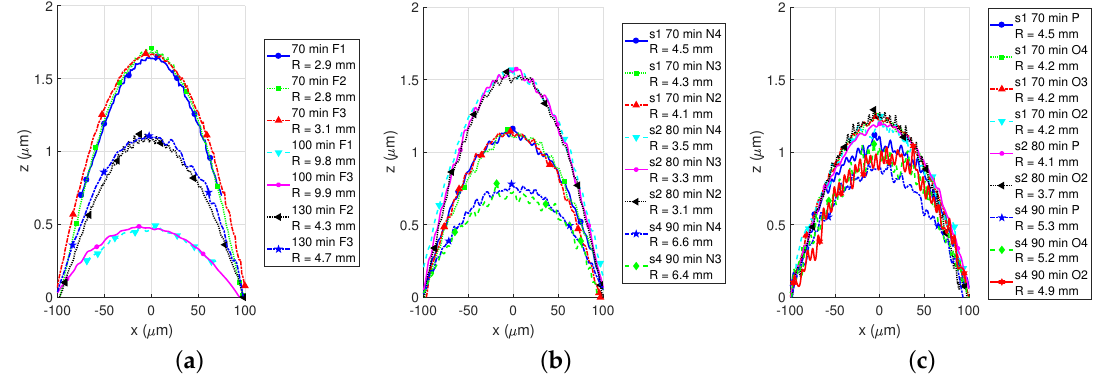
Figure 11. Plate curvature comparison: TM1 plates on Accused ( a ) , TM2 plates ( b ) and TM2-TVia2-TM1 plates from the same samples on Bailed ( c ). Data were clipped on 100 µ m radius from a plate center.